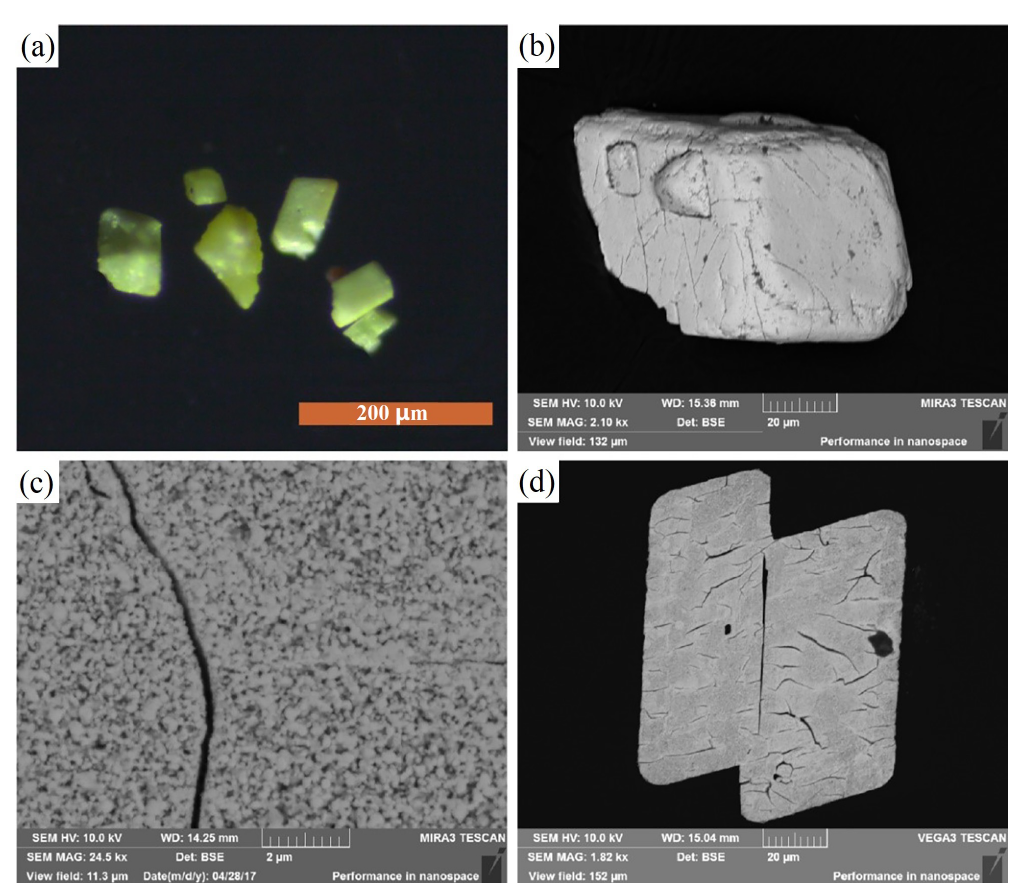
Figure 2. Photos and back-scattered electron (BSE) images of the liguowuite. (a) Yellow grains of liguowuite, (b) BSE images of a liguowuite aggregate grain, (c, d) BSE images of a polished face. The liguowuite grain is composed of nanoparticles with many cracks and nanovoids.